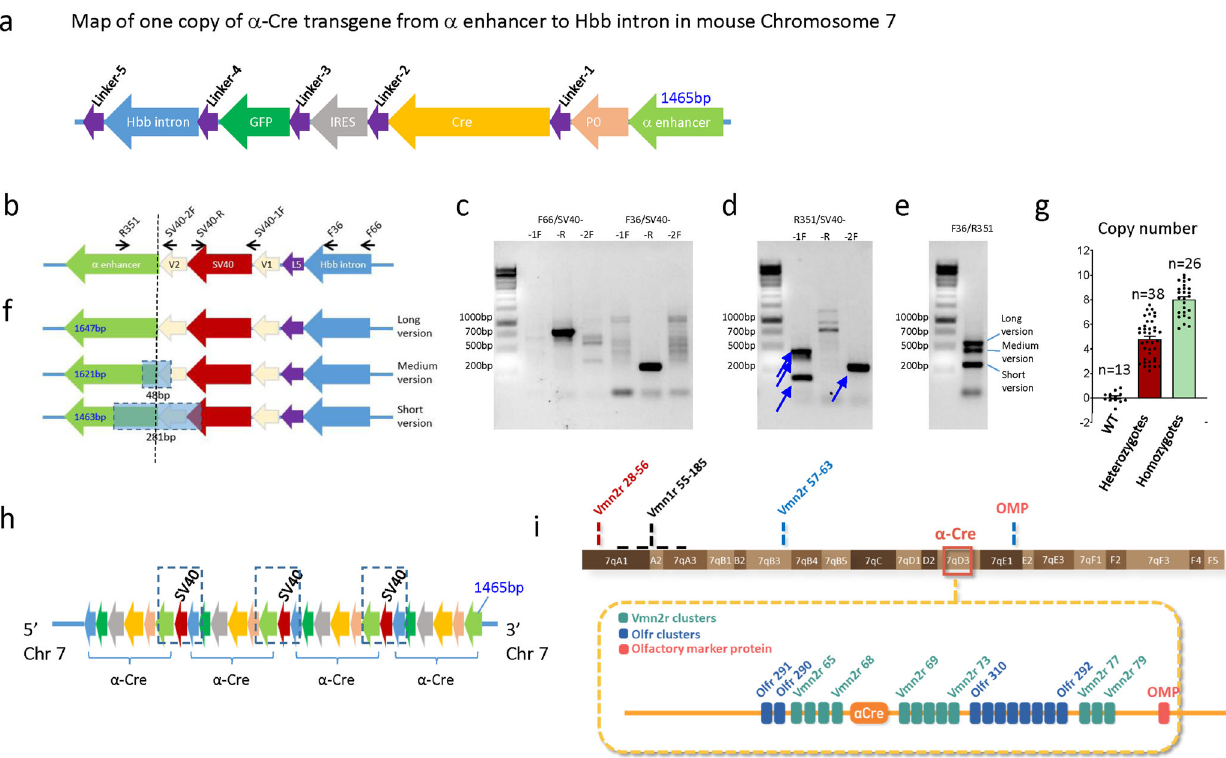
Fig. 3 Evidence for four tandem transgene copies. a Sequences from various PCR fragments were stitched together to deduce the arrangement of the α - Cre transgene, including the linker segments 1 – 5, but missing the SV40 polyA tail. The 1465 bp α enhancer shown here is adjacent to the 3 ′ side of chromosome 7. The position of the SV40 polyA tails and other tandem copies of the transgene were deduced in b – h . b Schematic showing the predicted junction between two tandem transgenes; the vertical dashed line indicates the junction site. The indicted primers were used to deduce the relationship between SV40 polyA signal and the Hbb intron or α -enhancer. c Primers from the Hbb intron (F66, F36) and SV40 polyA signal (SV40-1F, -2F, -R) con fi rmed that the SV40 signal is downstream of the Hbb intron. d Primers from the α -enhancer (R351) and SV40 polyA signal (SV40-1F, -2F, -R) con fi rmed the existence of tandem transgene copies. Blue arrows indicate multiple bands with R351/SV40-1F, but only one band with R351/SV40-2F primers. e Primers from Hbb intron (F36) and the α -enhancer (R351) con fi rmed three versions of the SV40/ α -enhancer junction. f Schematic, based on sequencing of the PCR produces in e showing the relationship between long, medium and short versions of the SV40/ α -enhancer junction. Dashed boxes (48 bp or 281 bp) indicate the deleted regions. g Quantitative PCR was used to measure transgene copy numbers in WT mice versus those that were heterozygous or homozygous for α -Cre. The data is mean ± SE. h Schematic showing 4 tandem copies of the α -Cre transgene in the chromosome 7 insertion site. The dashed boxes highlight the regions shown in more detail in b , f . Note that only three copies include the SV40 polyA signal, and the α - enhancer is a slightly different size in each copy (see sizes in f ). Apart from the right-most copy, the order of these variants along the chromosome is undetermined. i Schematic showing α -Cre location relative to the entire chromosome and select chromosome 7 loci (top), and the neighboring Vmnr2 and Olfr clusters within 7qD3 (bottom, dashed orange box). Hbb , hemoglobin beta gene; L5, linker 5; OMP , Olfactory marker protein gene; V1, V2 vector sequence 1 and 2 fl anking the SV40 polyA signal; Vmn1r , vomeronasal receptor 1; Vmn2r , vomeronasal receptor 2; Olfr , olfactory